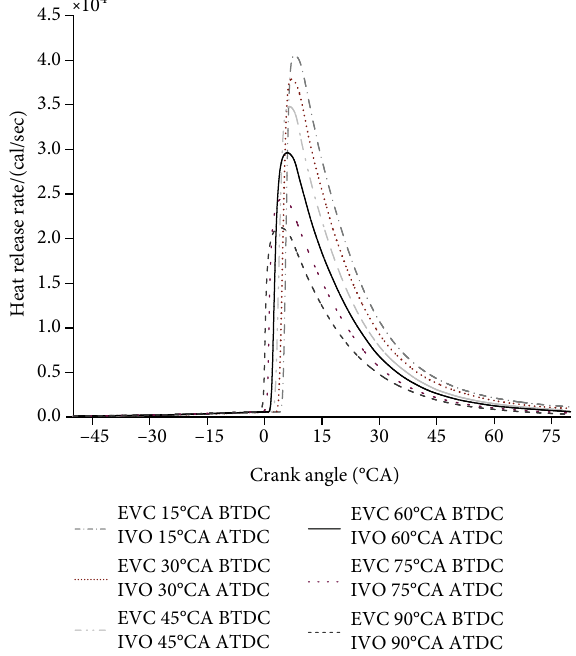
Figure 24: E ff ect of symmetric NVO on heat release rate.